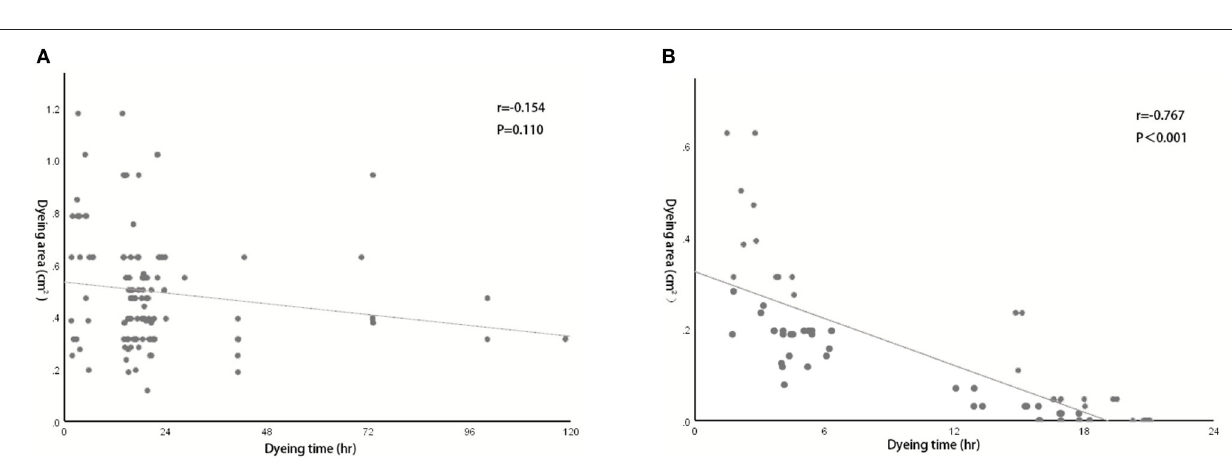
FIGURE 6 | Correlation between dyeing time and dyeing area. (A) Correlation in the CNSL group ( r = − 0.154, P = 0.110). (B) Correlation in the MBL group ( r = − 0.767, P < 0.001).